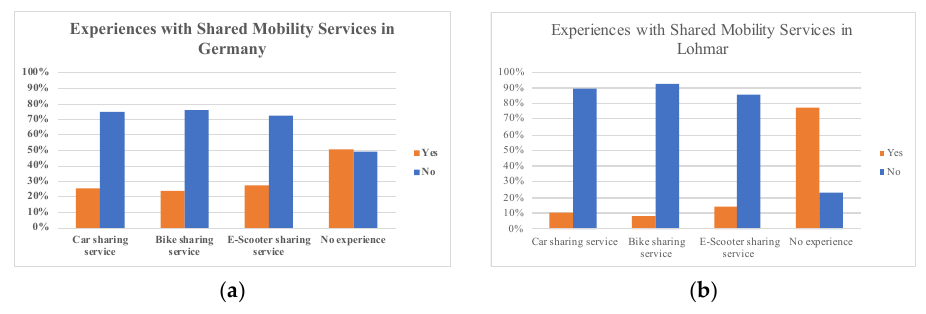
Figure 3. Experience with SMS: ( a ) Germany vs. ( b ) Lohmar.